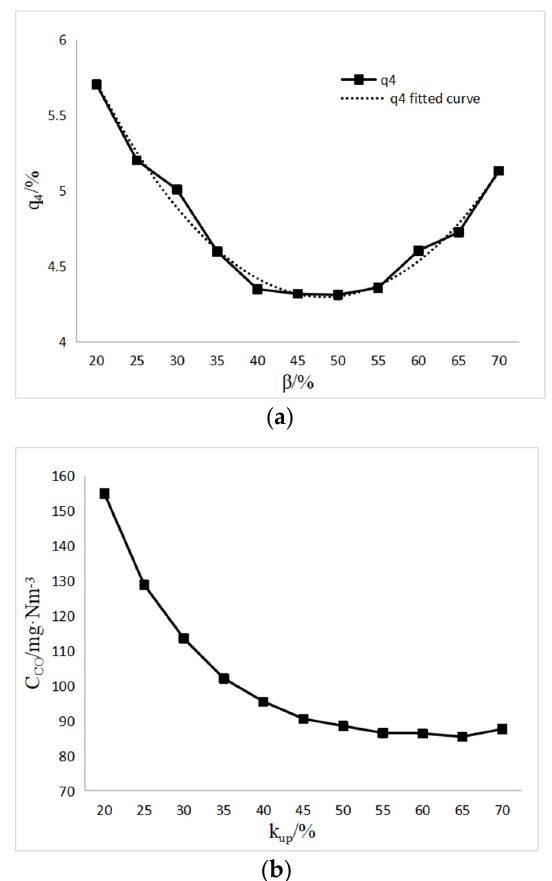
Figure 5. Influence of β on q 4 and CO emission concentration. ( a ) Influence of β on q 4 . ( b ) Influence of β on CO emission concentration.